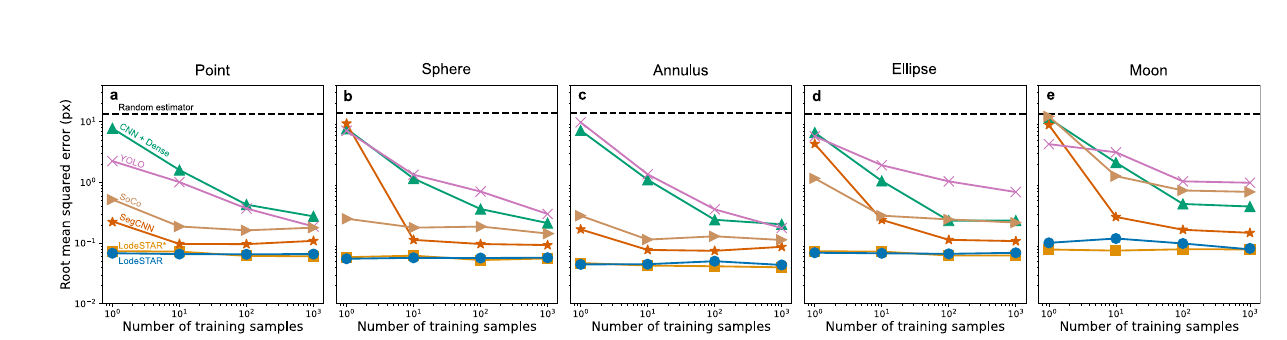
Fig. 2 | Evaluation positioning accuracy of object detection methods. The root mean squared error of the position accuracy for six methods, a CNN with a dense top 42 , YOLOv4 25 , SoCo 18 , a segmentation CNN 7 , LodeSTAR * (which is the archi- tecture of LodeSTAR trained in a supervised manner), and LodeSTAR. Each model was trained according to the recommendations of the corresponding paper. The performance of the model was evaluated on a separate validation set of 1000